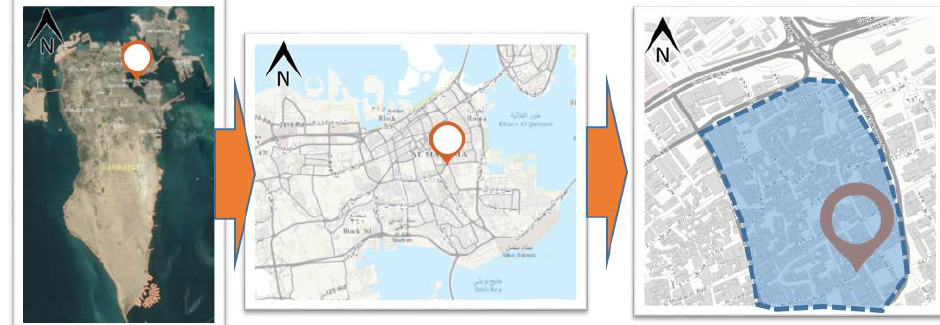
Figure 145: Al-Fadhel District relate to Bahrain and Manama Governorate map (google map 2018)